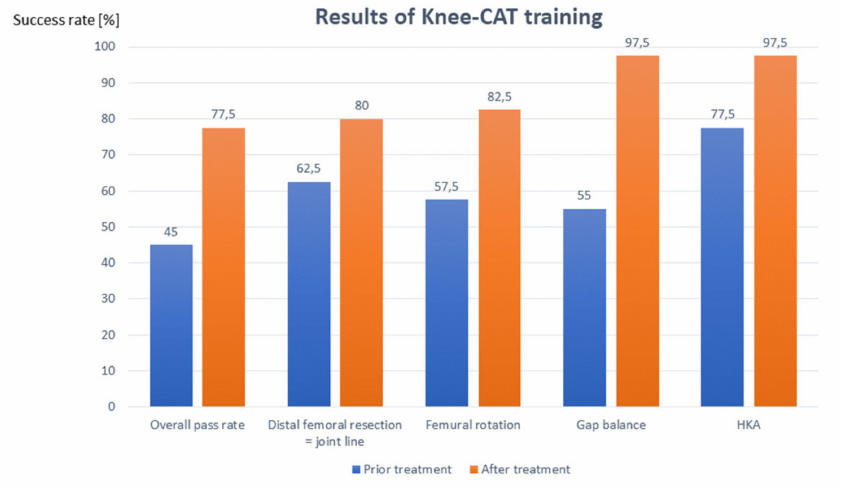
Figure 6. Summary of the results showing the overall improvement after Knee-CAT training. The most common problems were the distal femoral cut, femoral rotation, and gap balancing. Each category was again improved after training, with gap balance and HKA to almost